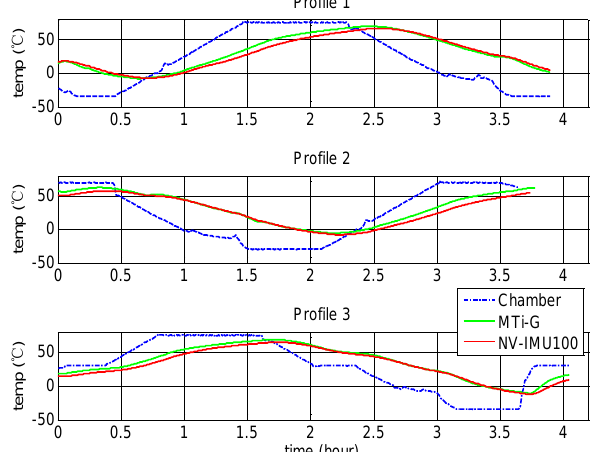
Figure 4. Temperature profiles in proposed method